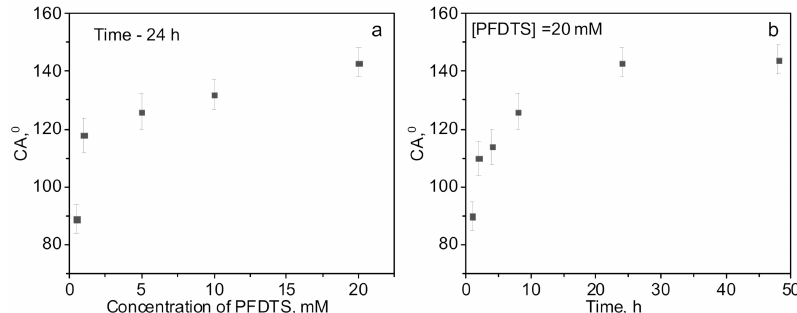
Figure 4. CA of PET-Si-F membranes at di ff erent reaction time ( a ) and concentrations of PFDTS ( b ) (the average pore size of the original membrane is 247 nm).